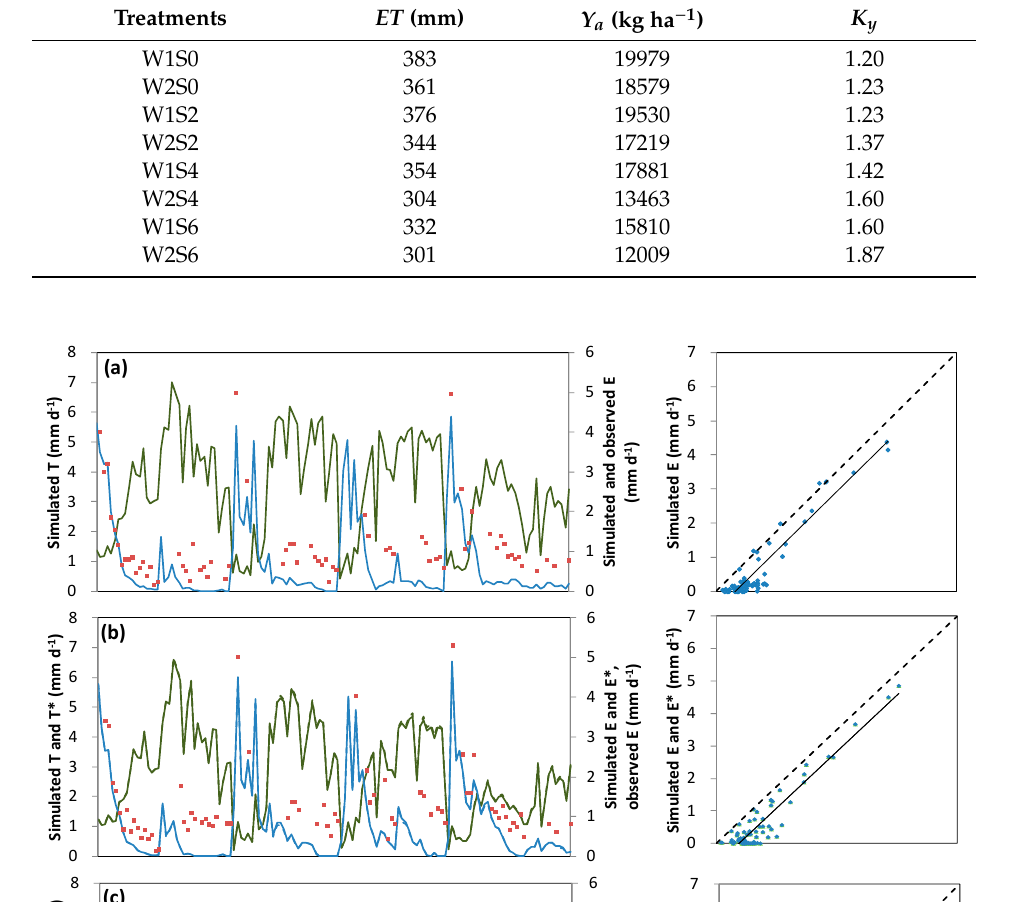
Table 4. The recalculated water-yield response factor ( K y ) of alfalfa using simulated evapotranspiration ( ET ) and measured hay yield ( Y a ) in 2018.